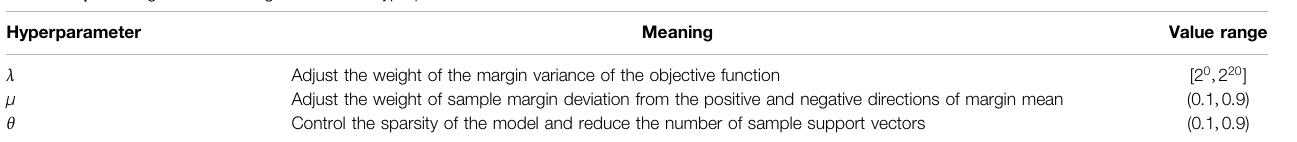
TABLE 5 | Meaning and value range of ssODM